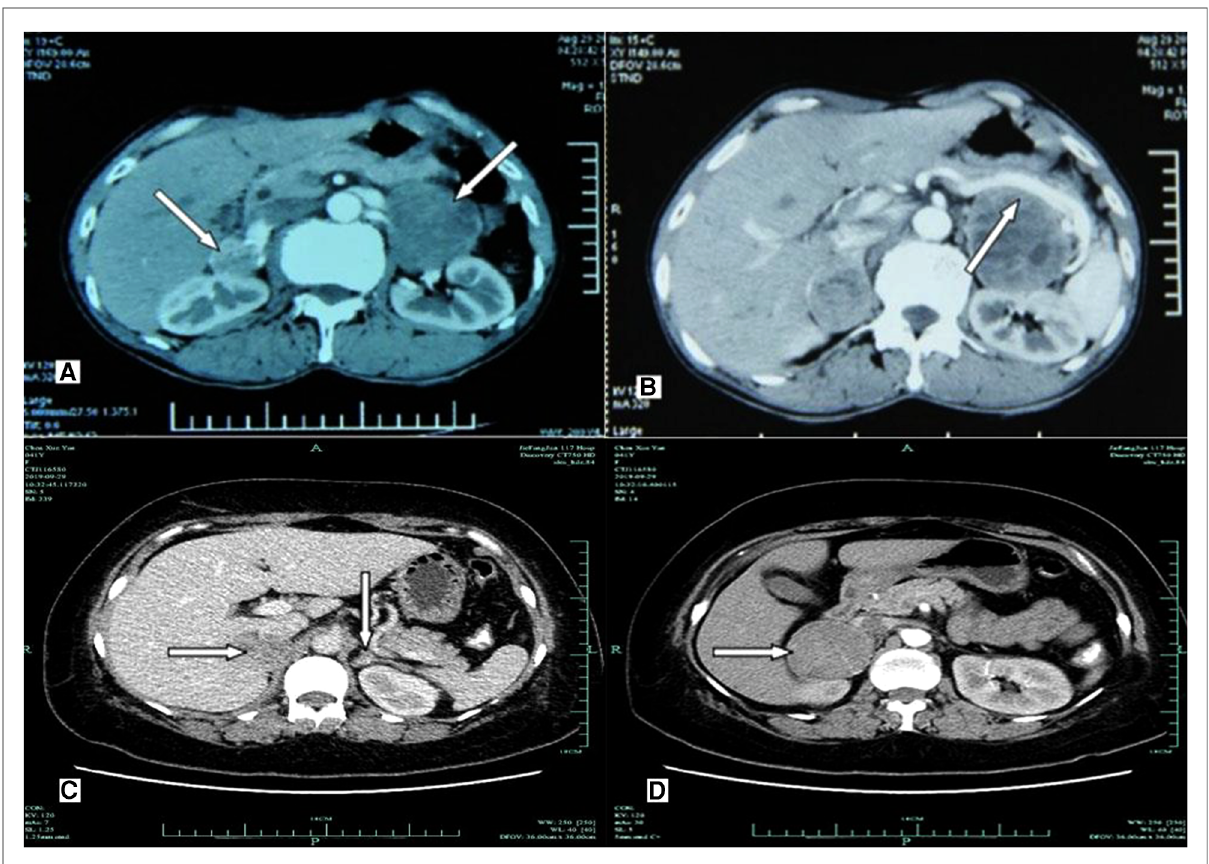
FIGURE 2 Imaging examination of computerized tomography scanning using ultravist 300 disclosed hypoechoic nodules in bilateral adrenal glands. ( A,B ) A 36- year-old male patient (P14; RET -C634Y) presenting with primary bilateral multifocal pheochromocytoma. ( A ) CT scan showing irregular enhancement of multiple nodules with intact capsule in both adrenal glands. ( B ) Contrast-enhanced CT imaging revealing inhomogeneous nodules with well-de fi ned and heterogeneous enhancement in both adrenal glands (white arrows). The maximum diameter of tumors was 6.0 cm×5.3 cm×4.8 cm in the left, and the maximum diameter was 5.2 cm×4.5 cm×3.0 cm in the right, while having multiple low density lesions with no obvious enhancement, respectively. No areas of obvious necrosis or hemorrhage were observed. The splenic artery and vein showed compression and displacement (white arrow). ( C,D ) A 40-year-old female patient (P29; RET -C634Y) having bilateral pheochromocytoma. ( C ) Contrast-enhanced CT scanning showing that two primary inhomogeneous nodular and heterogeneous mild/moderate enhancement in the right adrenal (white arrows). A nodule (1.2 cm×0.8 cm×0.6 cm) with equal density in the left adrenal gland was enhanced to the same extent as the Normal adrenal tissue (white arrows), as possibility of recurrence of pheochromocytoma. ( D ) Larger one with clear boundary in the right adrenal was about 5.3 cm×4.3 cm×3.0 cm in diameter (white